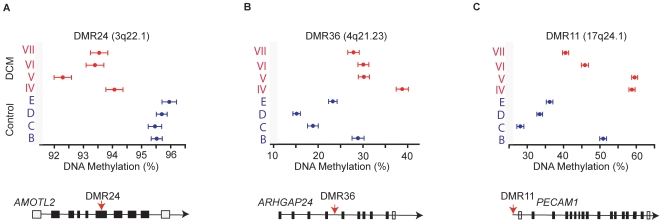
Differential DNA methylation profile for 3 candidate CM-DMR.(A) DMR24, (B) DMR36 and (C) DMR11. DNA methylation (%) was determined for a set of 8 LV samples (4 controls: B–E, 4 diseased (CM): IV–VII) by BS-PCR-sequencing as detailed in methods. Lower panel, DMR24 and DMR36 lie within the body of the genes: AMOTL2 and ARHGAP24; whereas DMR11 lies in the 5′ regulatory region of PECAM1.